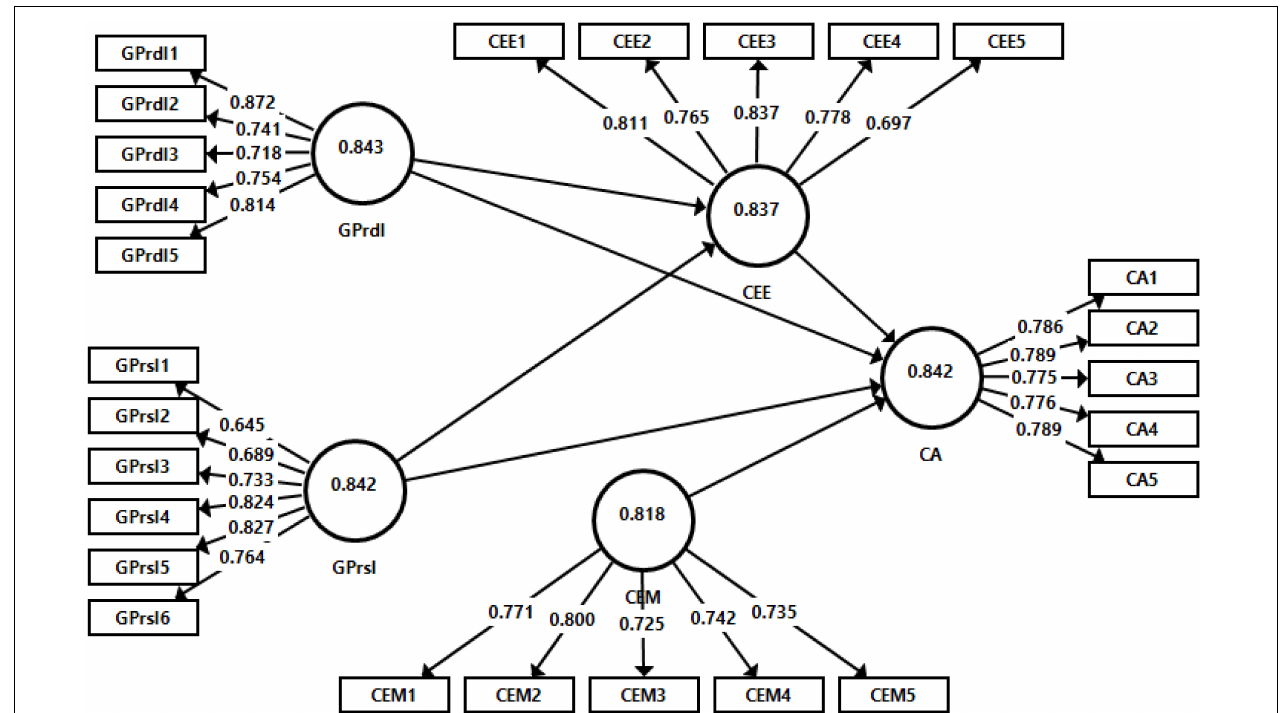
FIGURE 2 | Measurement model